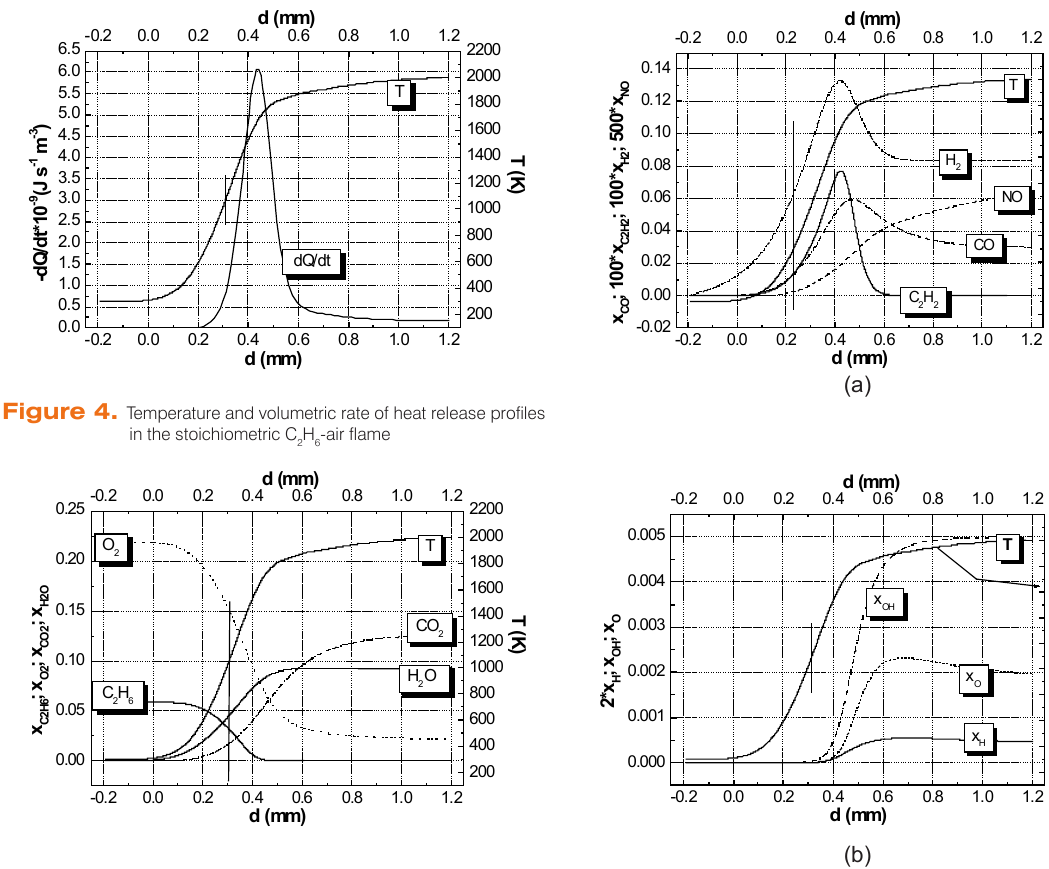
Figure 5. Mass fractions profiles of reactants and major products in the stoichiometric C